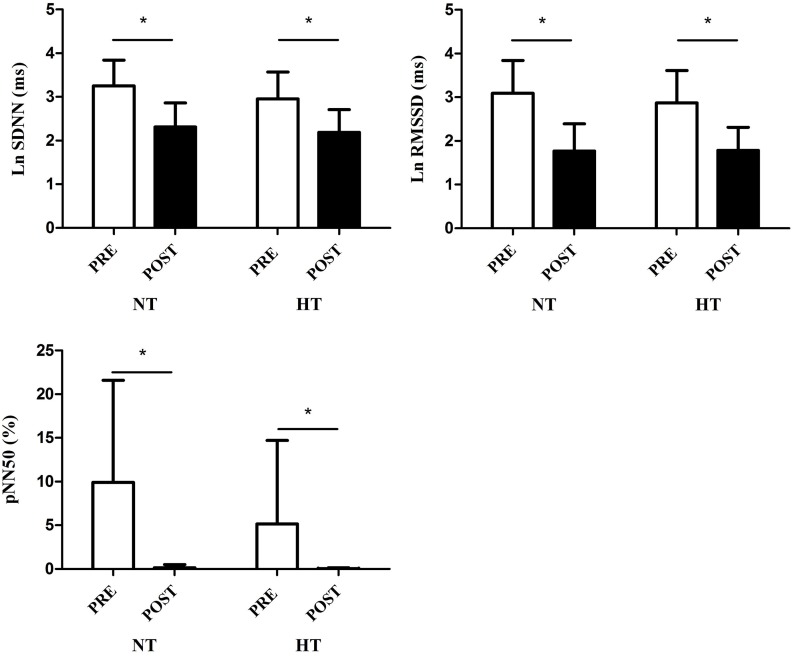
Time-domain heart rate variability indices (SDNN, RMSSD, and pNN50) at rest (PRE) and during 5–10 min of recovery (POST). HT, hypertensive group; NT, normotensive group; *
p < 0.05.